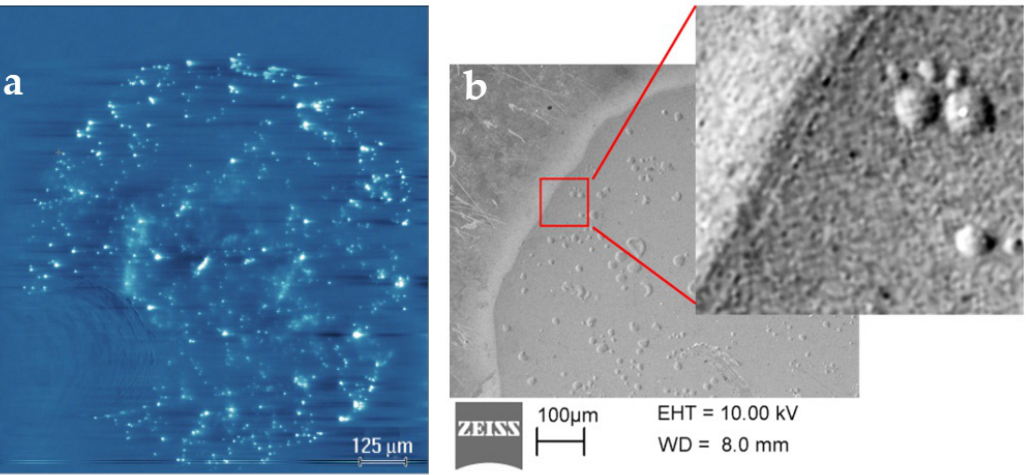
Figure 4. EBIC images obtained on Al/GO/n-Si MIS structure after HRS-to-LRS transition at a compliance current of 100 mA ( a ); SE images of selected device areas showing modification of the aluminum surface ( b ).